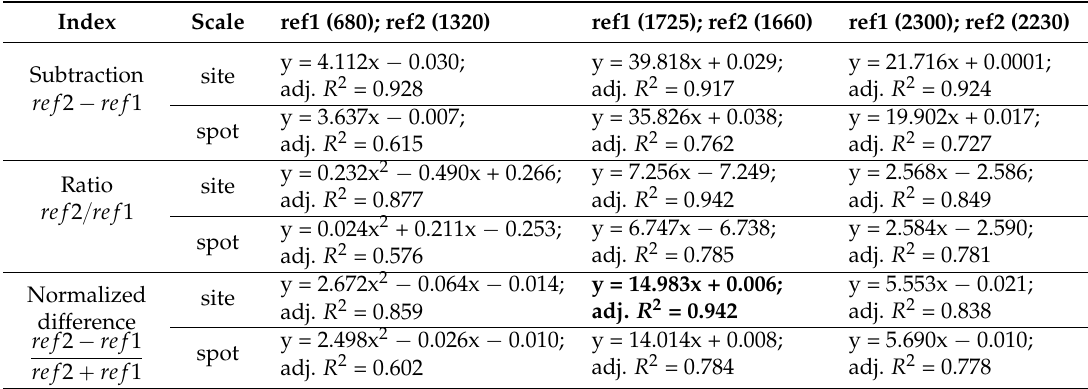
Table A3. Regression models for the lichen